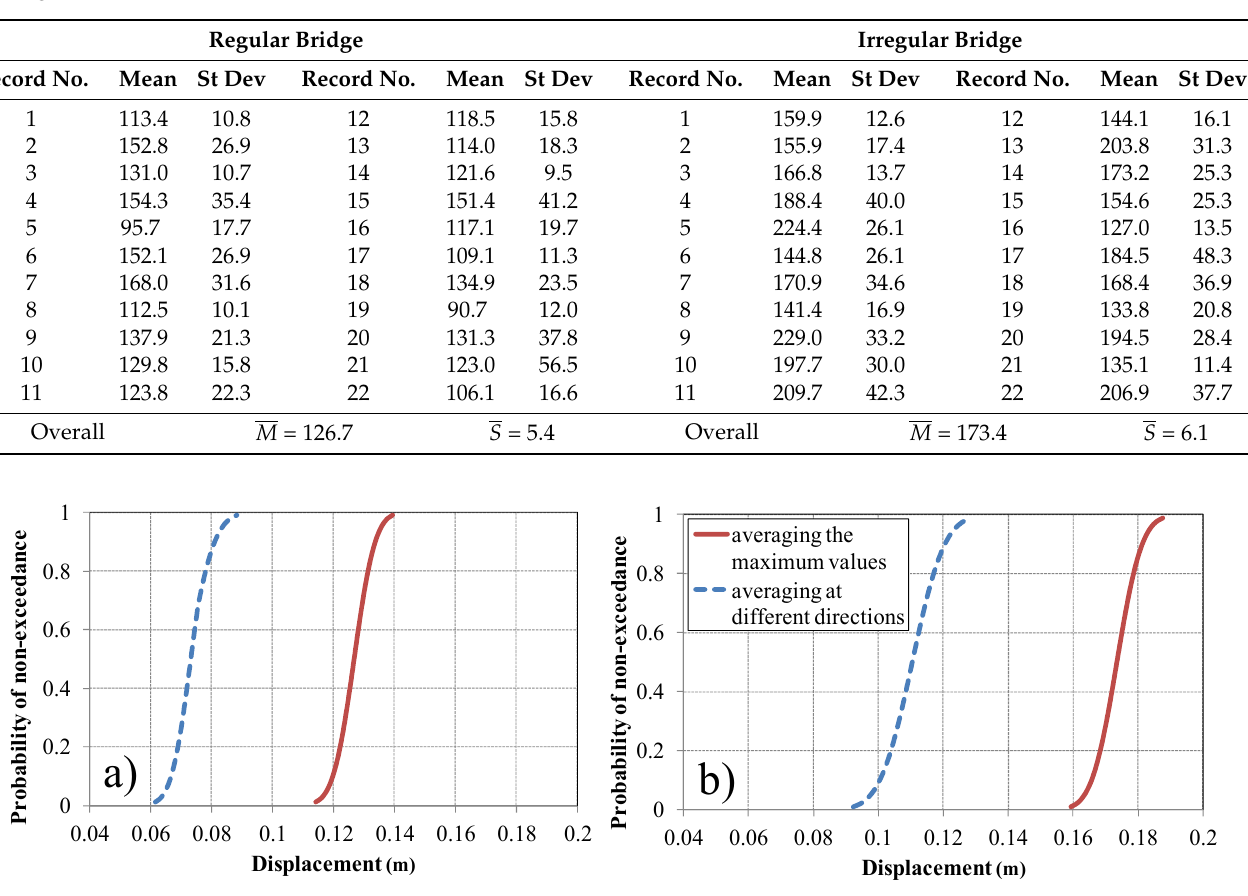
Table 5. Mean and standard deviation of the central column displacements (mm) for different records applied at different angles, θ . Regular Bridge Irregular Bridge